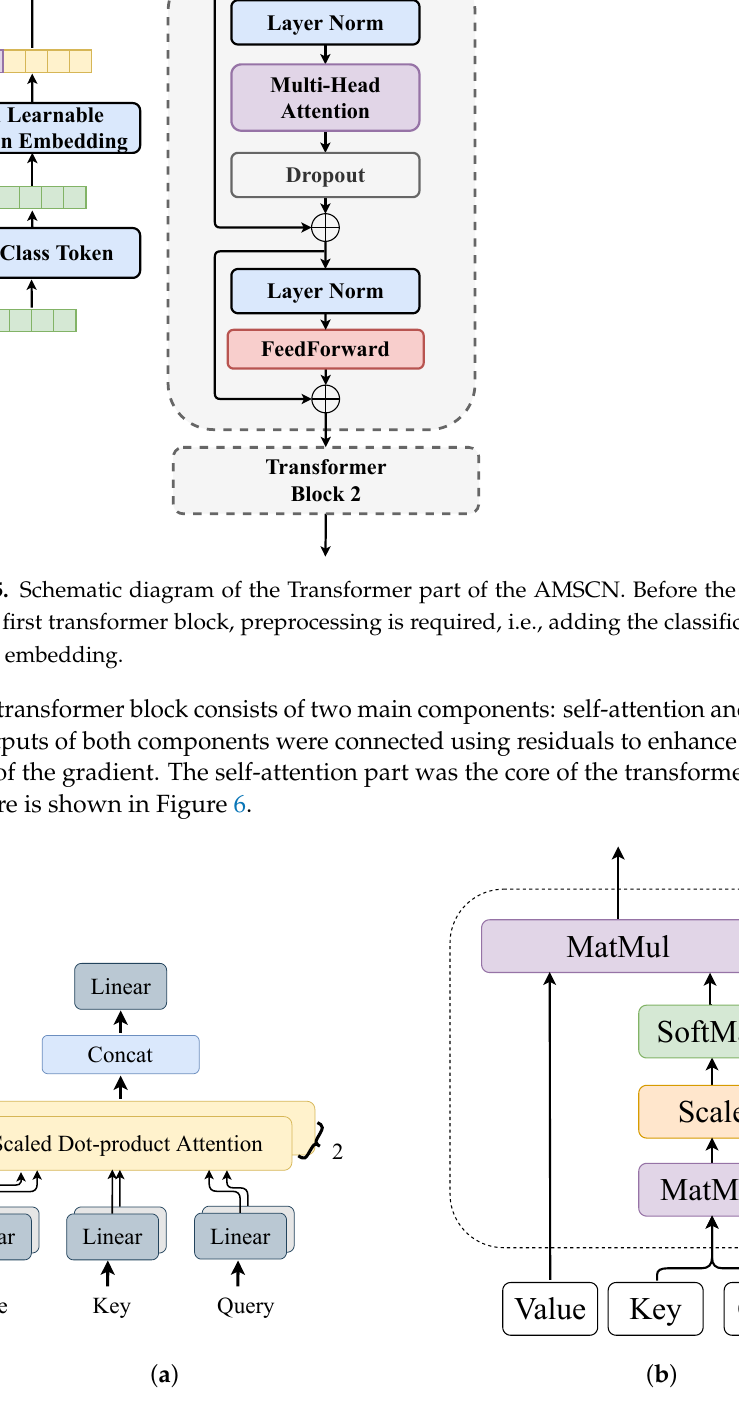
Figure 6. The structure of the self-attention part a transformer block. ( a ) Details of the multi-head attention structure. ( b ) Scaled dot-product attention